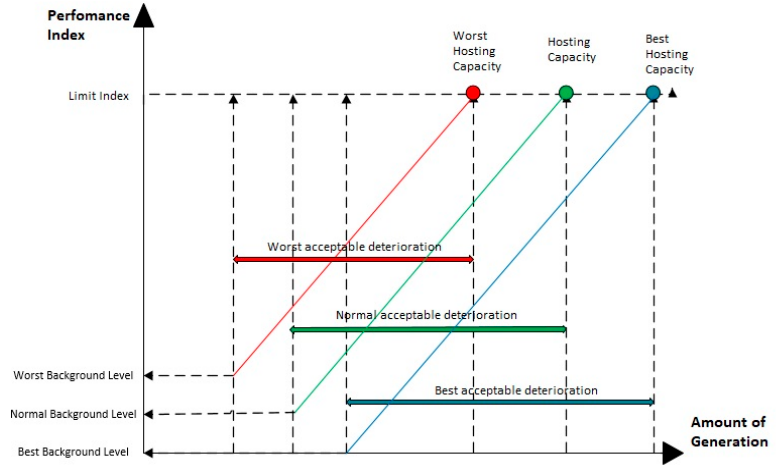
Figure 1. Range curves of a generic performance index versus the amount of distributed generation.